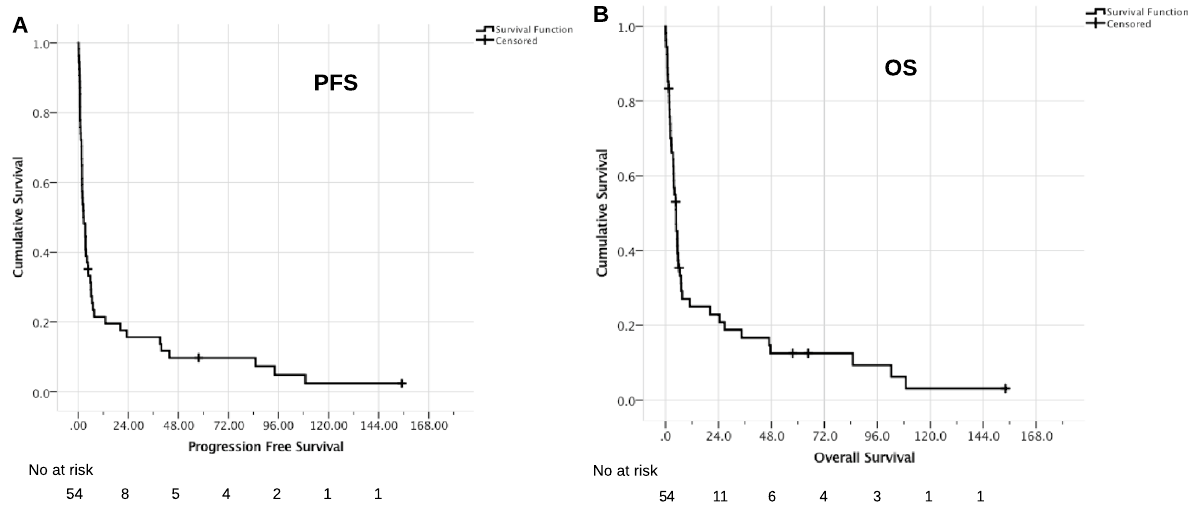
Fig. 2 Progression free survival ( a ) and overall survival ( b ) in patients with cerebral relapse/progression (n